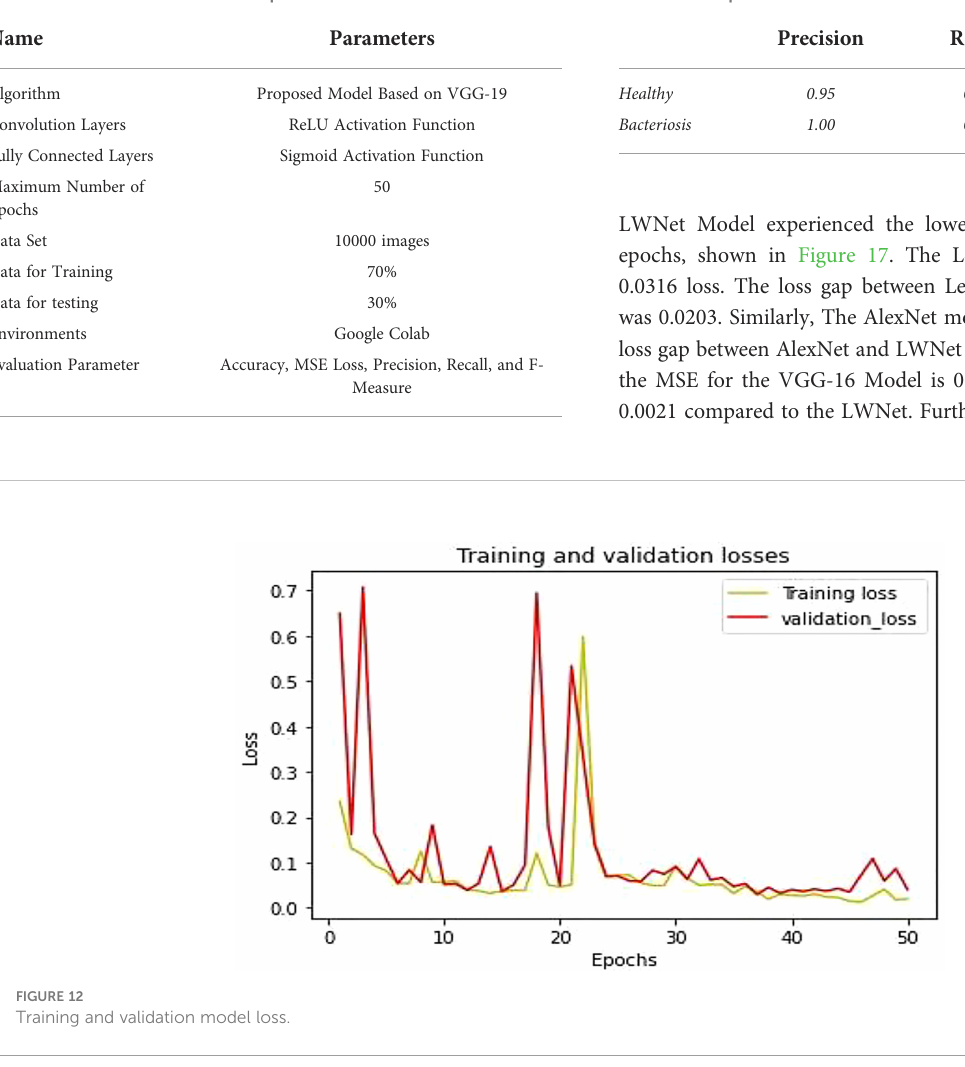
TABLE 6 Proposed Model Performance Parameter. TABLE 5 Parameters Detail of Proposed Model.